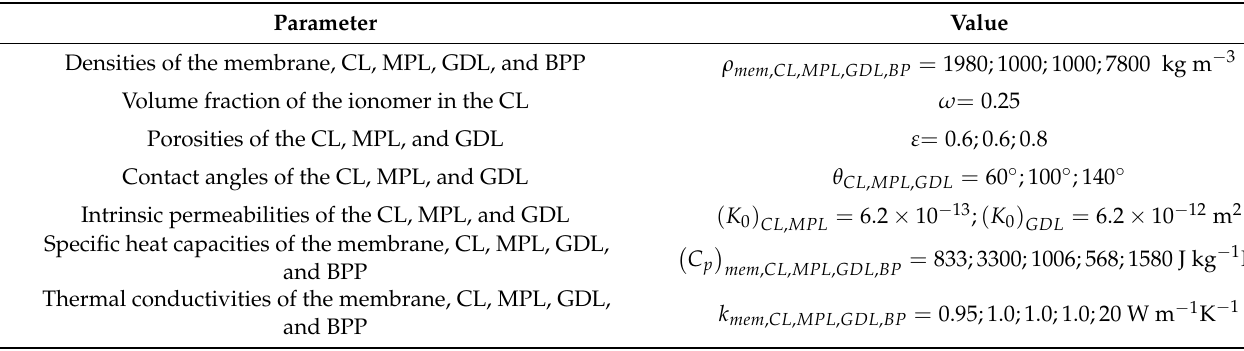
Table 5. Material properties [34,41,48].